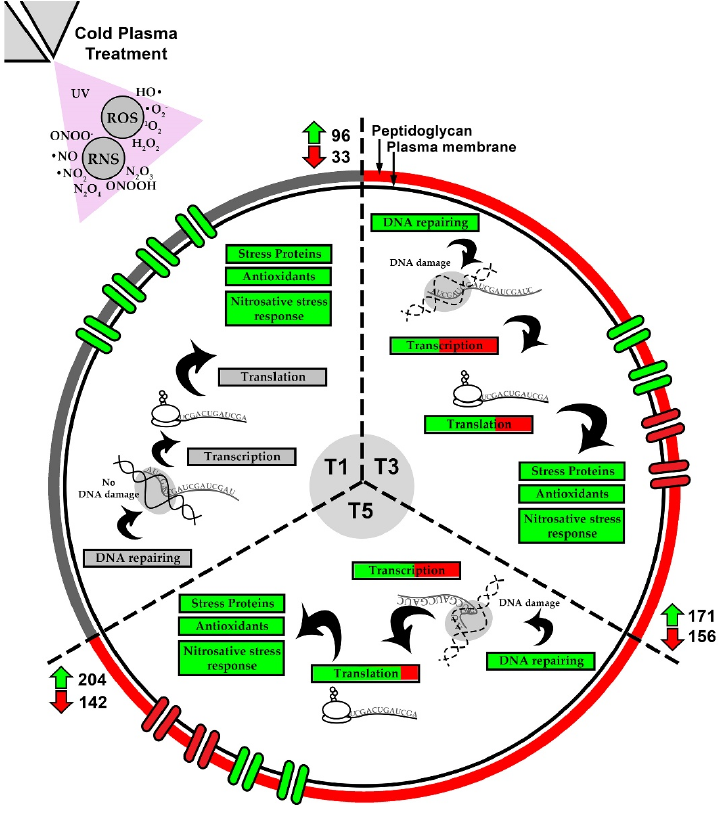
Figure 7. Sequential responses in biological processes of S. aureus revealed by comparative analysis of the three treatment settings (T1, T3 and T5).